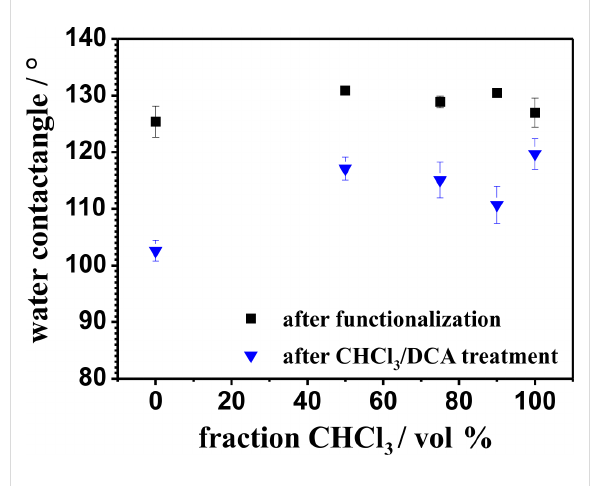
Figure 6: Water contact angles at the outer surface of the polypheny- lalanine functionalized ALOX-membranes after the grafting process (black squares) from different solvent mixtures and after a CHCl 3 /DCA treatment (blue triangles).